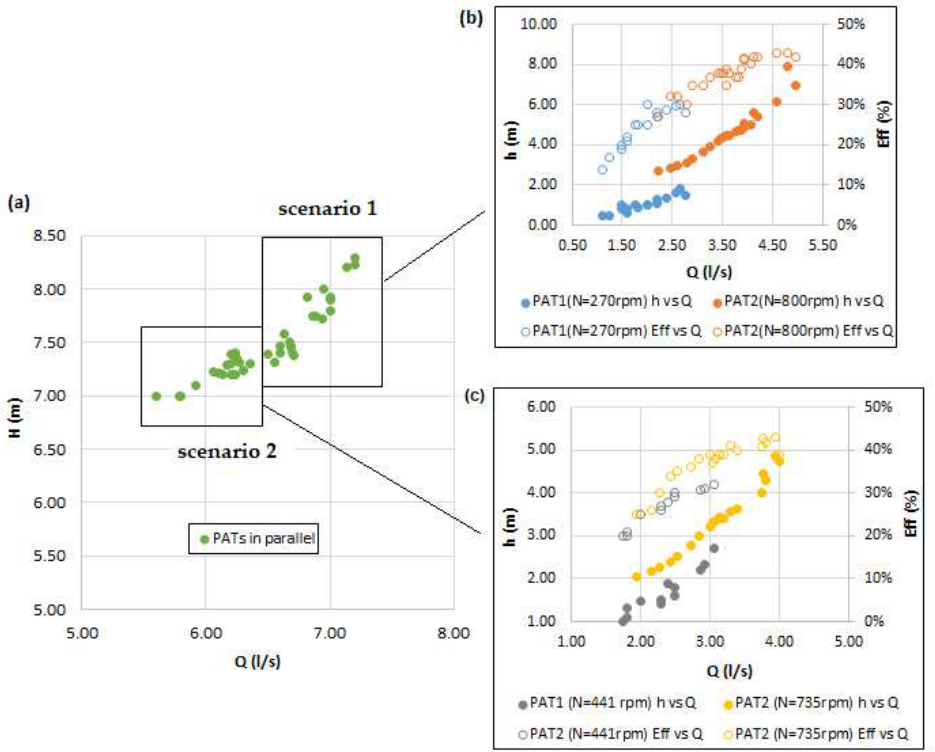
Figure 5. Parallel PATs in operation: ( a ) global system of two PATs in parallel: scenario 1—total flow range between 5.80 L/s and 6.60 L/s, and scenario 2—total flow range between 6.70 L/s and 7.20 L/s; ( b ) scenario 1 by each PAT; ( c ) scenario 2 by each PAT.